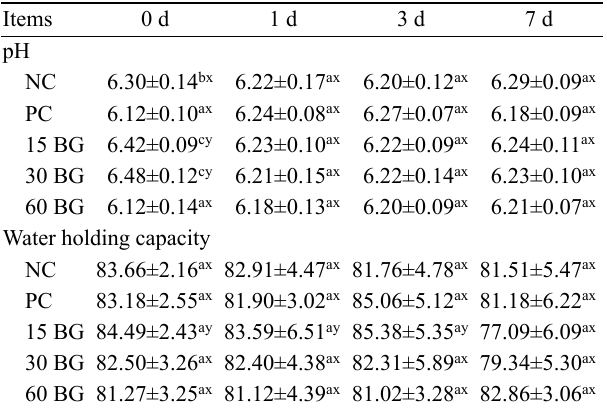
Table 5. Dietary effects of β-glucan on the pH values and the water holding capacity in broiler chickens